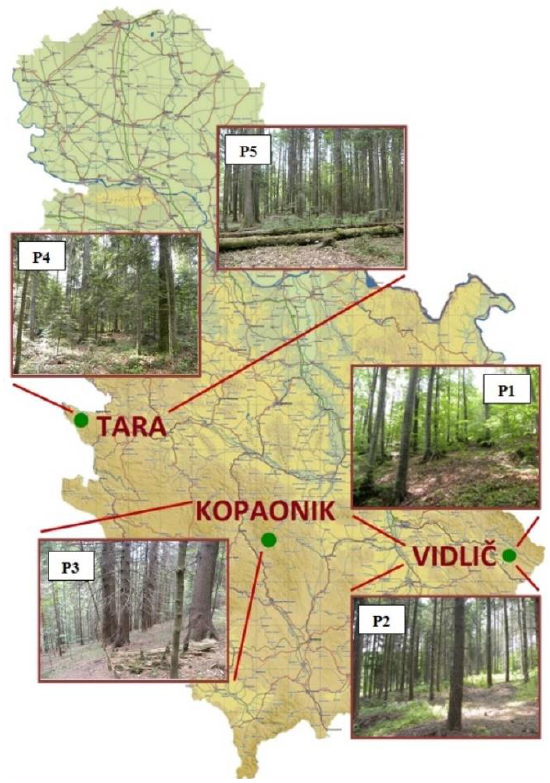
Figure 1. Map of Serbia, with locations of the study areas and representative forest plots.